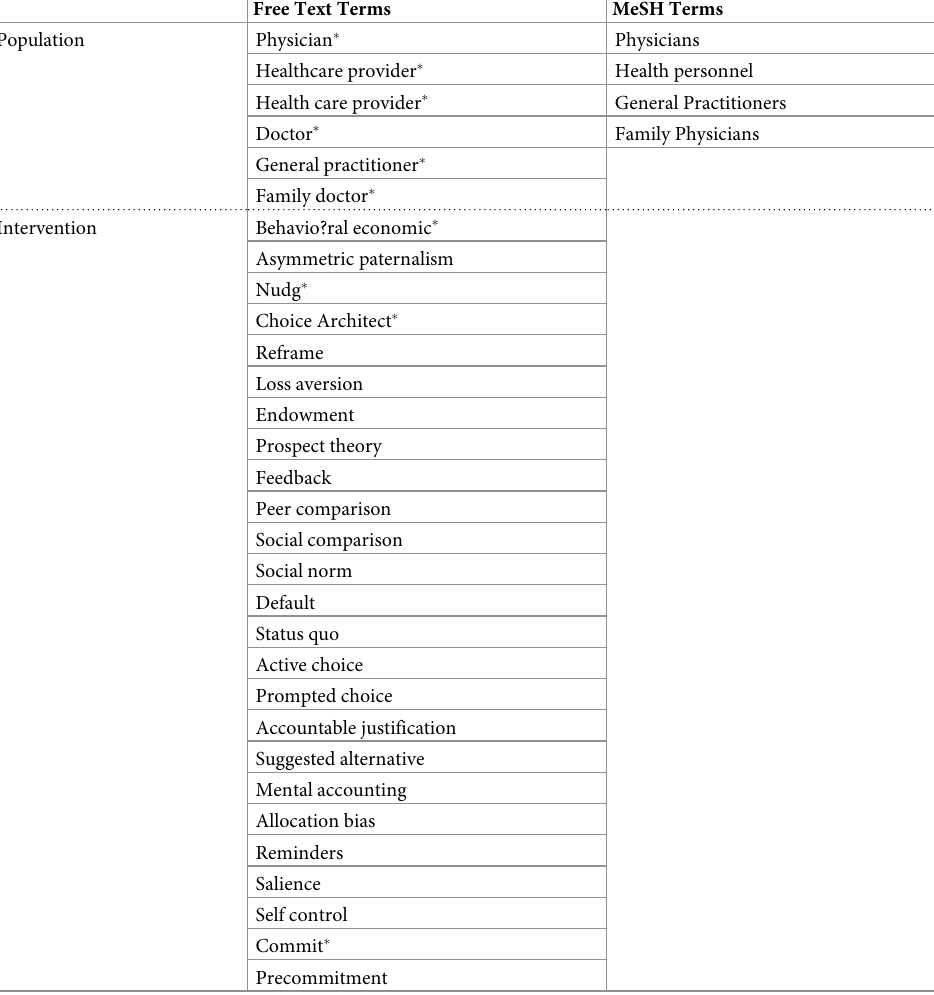
Table 1. Search terms used for Medline (OVID)